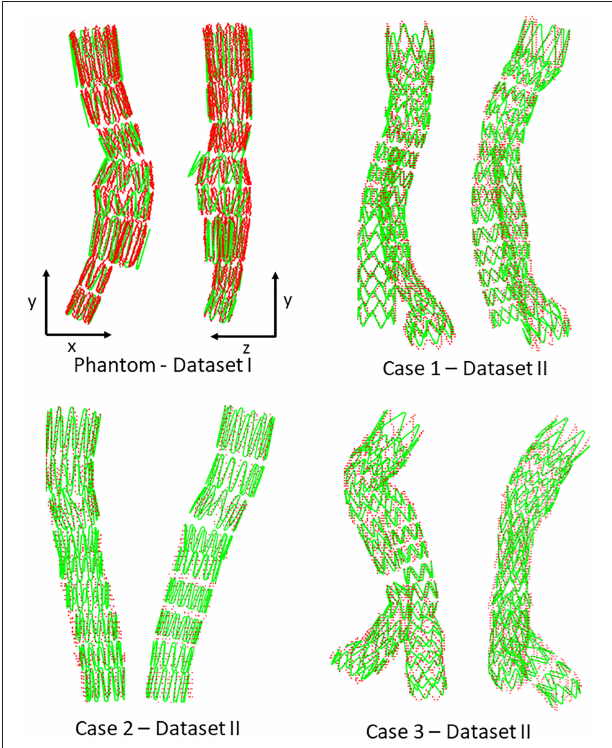
FIGURE 7 | Comparison between simulation (green) and target stent graft (red), frontal view on the left, side view on the right. Reminder: Sources of error in Dataset I: ES fabric ; Dataset II: ES fabric and ES stiffness .